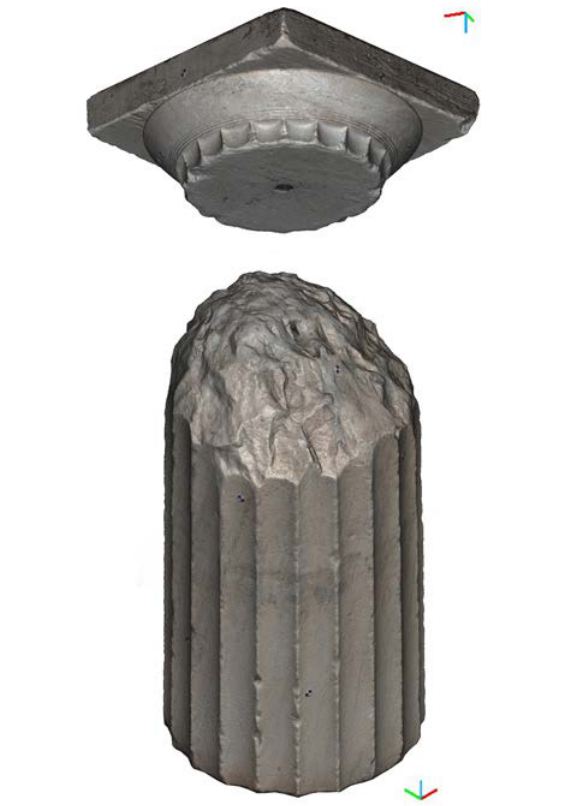
Figure 1.Doric capital and bottom column drum, which belong to the Nicias Monument. Point clouds produced with